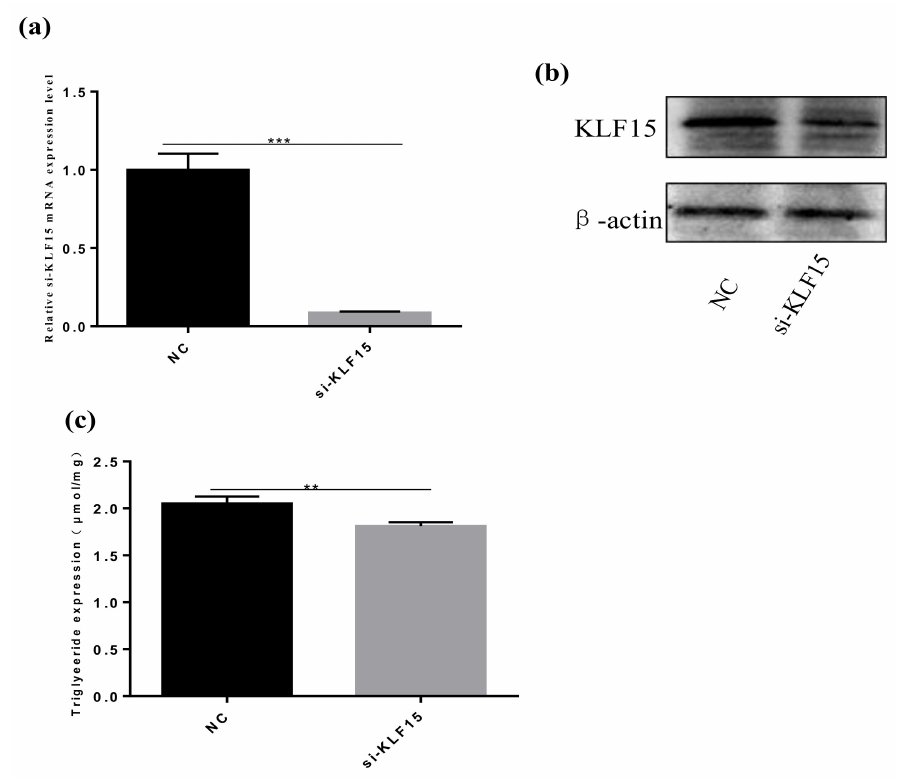
Figure 5. E ff ects of KLF15 on the metabolism of adipocytes in Qinchuan cattle. ( a , b ) The expression of KLF15 mRNA and protein in preadipocytes transfected with si-KLF15 and negative control cells were compared. ( c ) After si-KLF15 treatment, the triglyceride level of preadipocytes decreased. ** p ≤ 0.01, *** p ≤